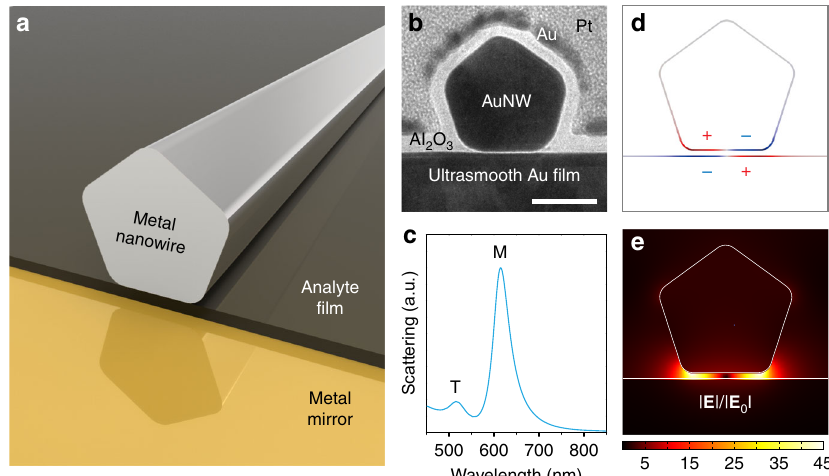
Fig. 1 Cavity plasmons in a NWOM setup. a Schematic of the NWOM system — a metal nanowire is separated from a metal mirror by a thin fi lm whose thickness change can be precisely probed. b High-resolution TEM cross-sectional image of a single NWOM system: a crystalline AuNW with a pentagonal cross section situated on an ultrasmooth gold fi lm separated by a 1.5-nm-thick Al 2 O 3 spacer. Further, a 8-nm-thick Al 2 O 3 layer is coated on the surface of the NWOM to make the shape of the nanowire clear. Scale bar, 30 nm. c Calculated scattering spectrum of a 45-nm-diameter AuNW on the gold fi lm with 2-nm vacuum separation, showing two resonant peaks corresponding to a transverse dipole mode (T) and the lowest frequency cavity-plasmon mode (M). d , e The surface charges ( d ) and the electric fi eld ( e ) distributions of the M